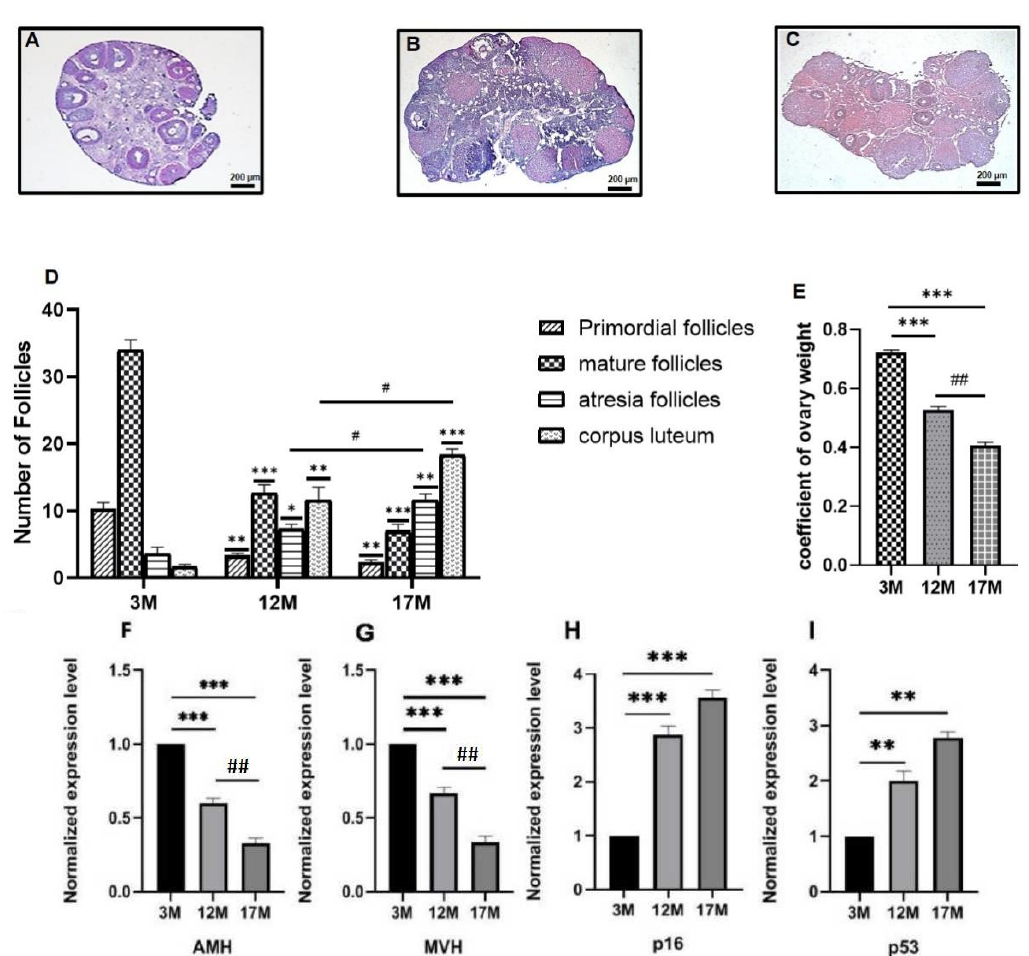
Figure 1. Changes of ovarian morphology and gene expression related to follicular development in mice of different ages. The dynamic changes of follicles during physiological ovarian aging in the mouse ovaries. ( A – C ) The detection of ovarian follicle depletion by HE-staining. ( D ) The number of primordial and mature follicles is reduced with increased age, but atretic follicles increased gradually. ( E ) The coefficient of ovary weight showed decreased from 3M to 17M. ( F – I ) Total RNAs from the ovaries of different age in mice were isolated and the expression of genes encoding reproductive function-related proteins was examined by quantitative real-time PCR using the 2 −ΔΔ Ct method. the relative mRNA expression of AMH and MVH were decreased significantly as mice aged; the aging marker genes p16 and p53 showed a significant increased among 12M and 17M mice compared with the 3M mice. The results are presented as the mean ± SD. * p < 0.05, ** p < 0.01, *** p < 0.001, compared with the 3M group. # p < 0.05, ## p < 0.01, , compared with the 12M group. Scale bars represent 200 μ m.